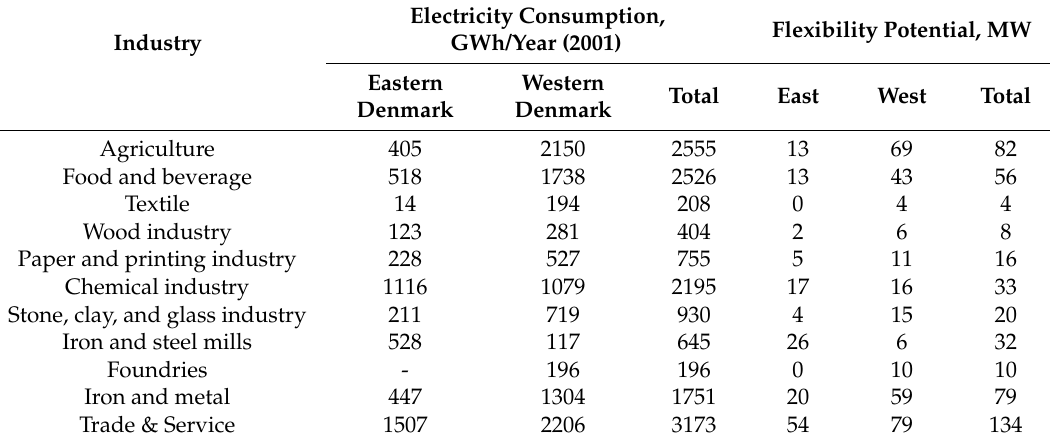
Table 3. Potential for load flexibility of different processes in agriculture and industry